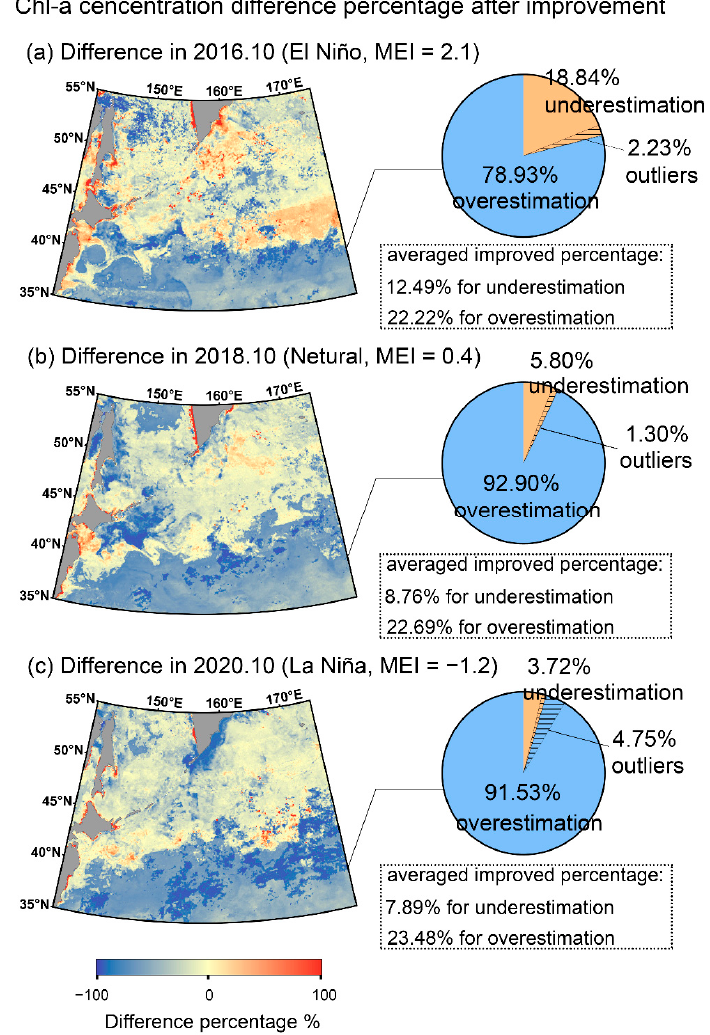
Figure 15. The differences of merged Chl-a data in different ENSO states compared with the satellite Chl-a data before improvement. ( a – c ) are the differences of Chl-a data after improvement and the pie chart of pixel statistics.